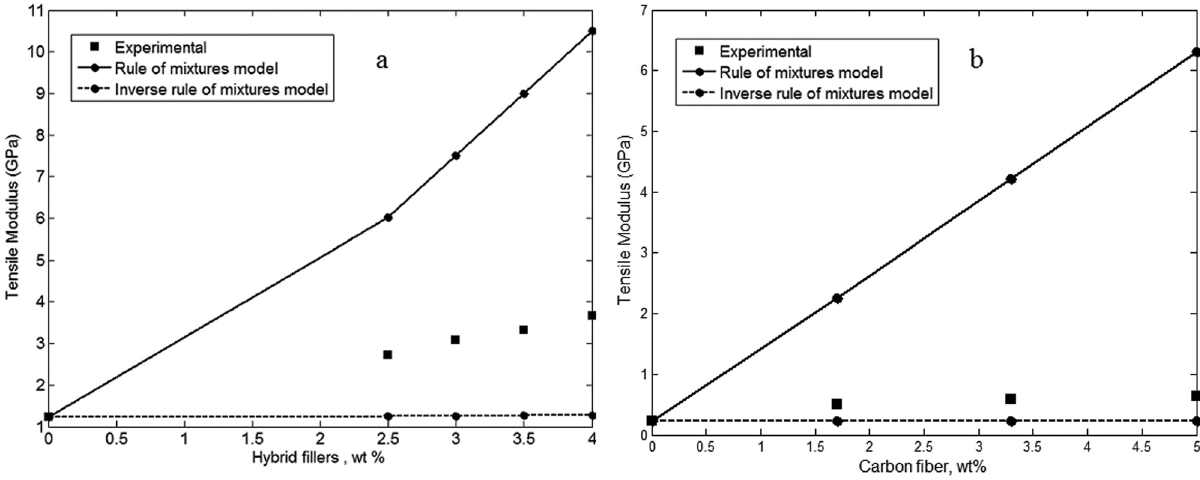
Figure 2: The calculations of modulus by rule of mixtures and inverse rule of mixtures models for ( a ) PS/MWCNT/SCF ( No. 1 ) and ( b ) PU/CNT ( No. 3 )